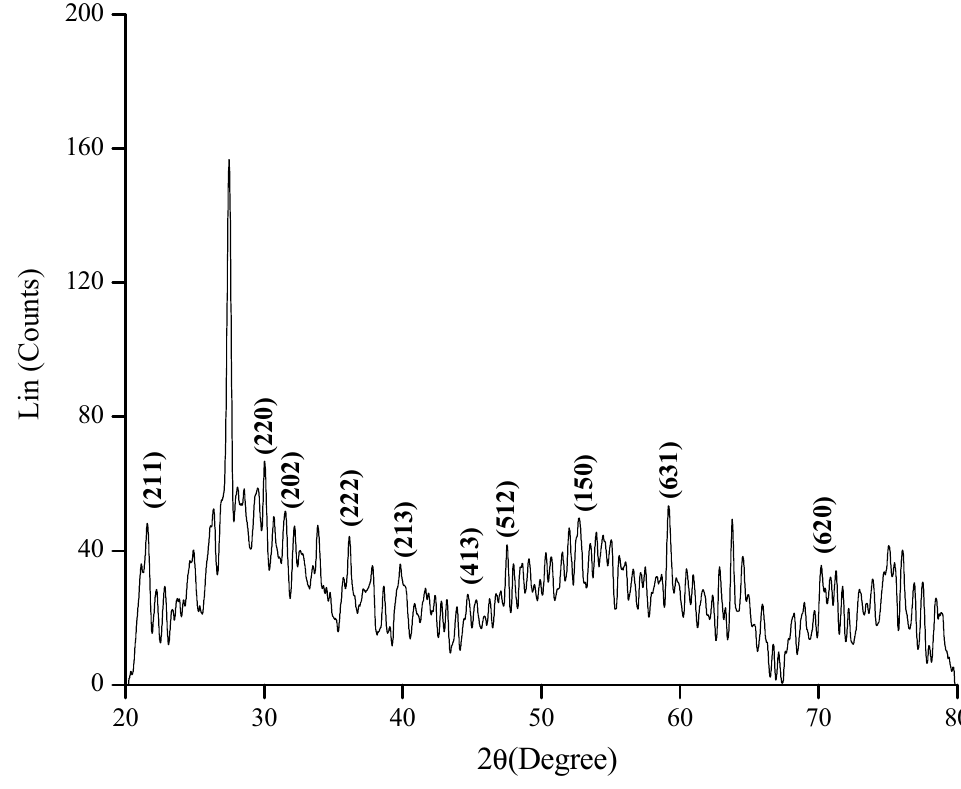
Figure 7. X-ray diffraction (XRD) pattern for synthesized iron oxide (Fe 2 O 3 ) nanoparticle. The figure illustrated that the peak intensity was found to be highest at a theta scale value of 27.4.